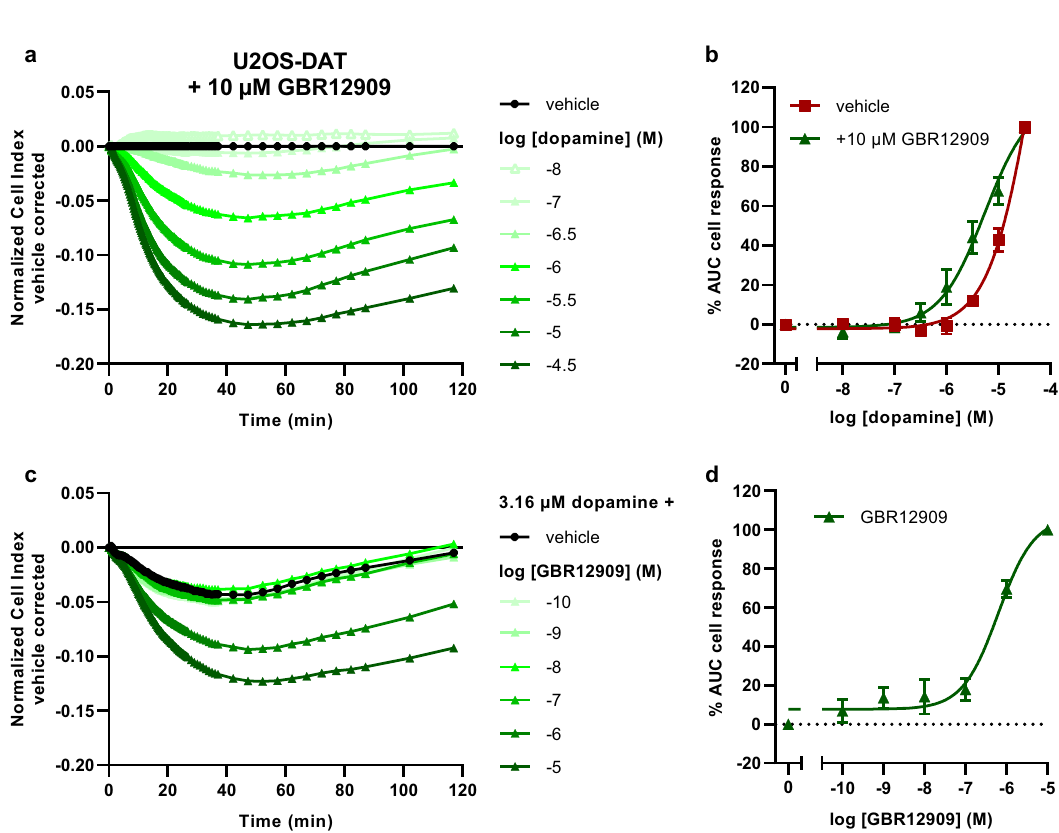
Figure 2. Functional characterization of GBR12909 on DAT in U2OS-DAT cells in a TRACT assay. Cells were pretreated with vehicle, 10 µM ( a,b ) or increasing concentrations ( c,d ) of GBR12909. Representative vehicle- corrected xCELLigence traces after stimulation with ( a ) increasing concentrations of dopamine or ( c ) 3.16 µM dopamine. ( b ) Concentration-effect curves of dopamine in U2OS-DAT cells pretreated with vehicle or 10 µM GBR12909 are shown as the net AUC of the first 120 min after stimulation normalized to the cell response of 31.6 µM dopamine. ( d ) Concentration-effect curve of GBR12909 after addition of 3.16 µM dopamine normalized to 10 µM GBR12909. Data are shown as mean ± SEM of three to six separate experiments each performed in